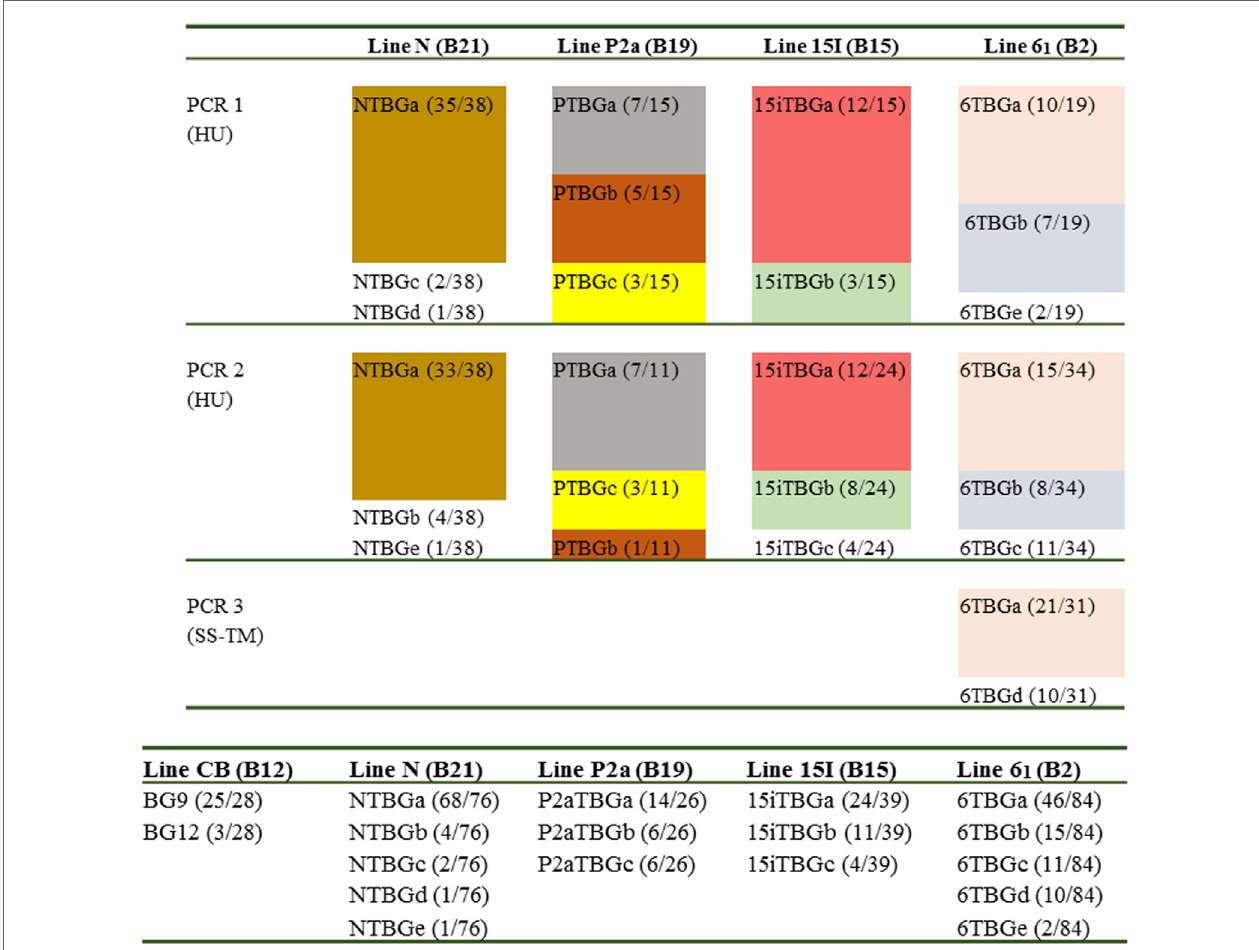
FigUre 2 | Overall results for the number of genes (based on exon 2 sequences) amplified from cDNA preparations derived from blood T cells isolated from various chicken lines (with different B haplotypes): line CB (B12), line N (B21), line P2a (B19), line 15I (B15), and line 6 1 (B2). Top panel, independent amplifications from the four chicken lines; HU, hemopoietic forward and “universal” reverse primers to give nearly full-length sequences; SS–TM, signal sequence forward and transmembrane reverse primers to give SS, extracellular Ig-V domain and TM regions. Different colors indicate different exon 2 sequences, except those sequences that are only found in one PCR reaction. Names follow the convention: abbreviated line name, “T” for T cells, “BG” and a letter representing the exon 2 sequence with “a” being the most frequently detected exon 2 sequence (and “b” being the second most frequently detected exon 2 sequence, and so forth); numbers in parentheses indicate the number of clones found for a particular exon 2 sequence out of the total number for the particular PCR reaction. Bottom panel, the total results for four chicken lines from this paper and for the CB line (B12) from Ref.